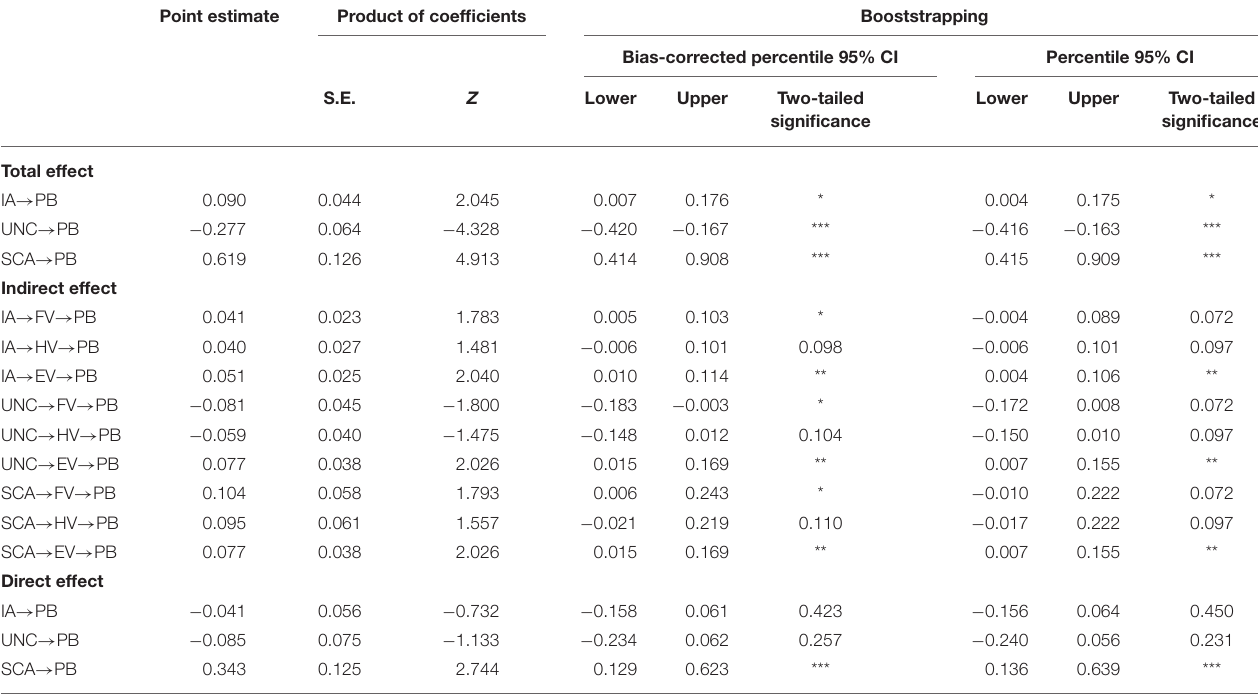
TABLE 9 | Total effects, indirect effects, and direct effects of the